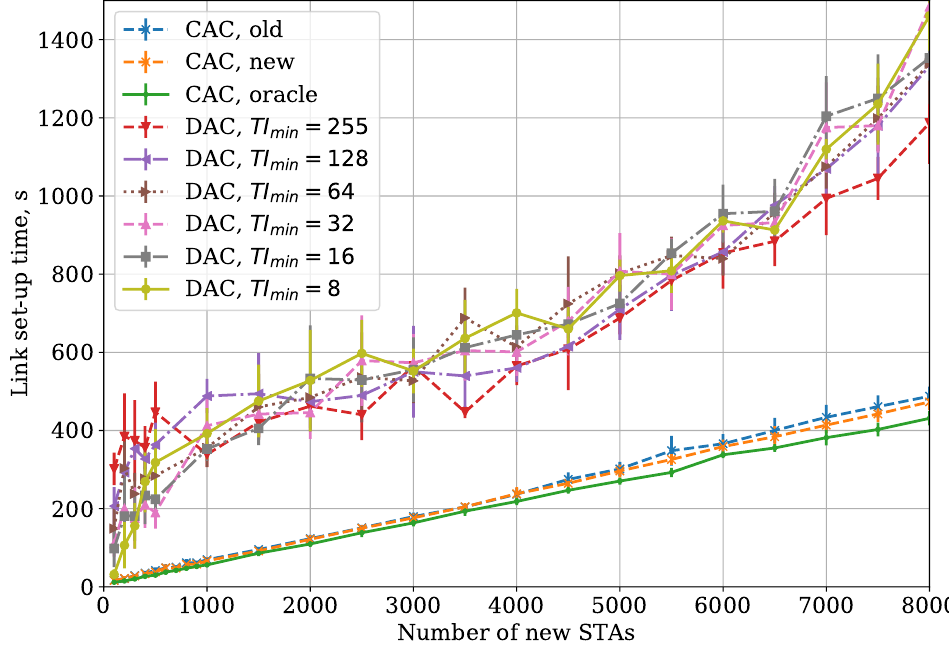
Figure 8. CAC and DAC protocols: dependency of link set-up time on the number of new STAs for the Two Groups